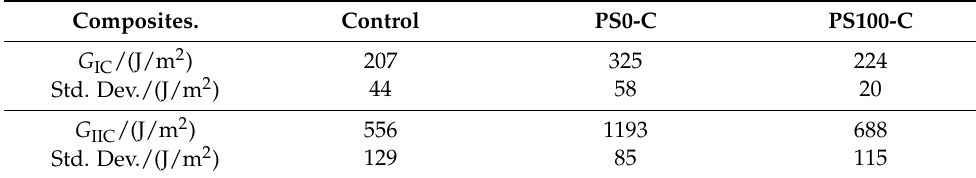
Table 2. The interlaminar toughness of the different samples.